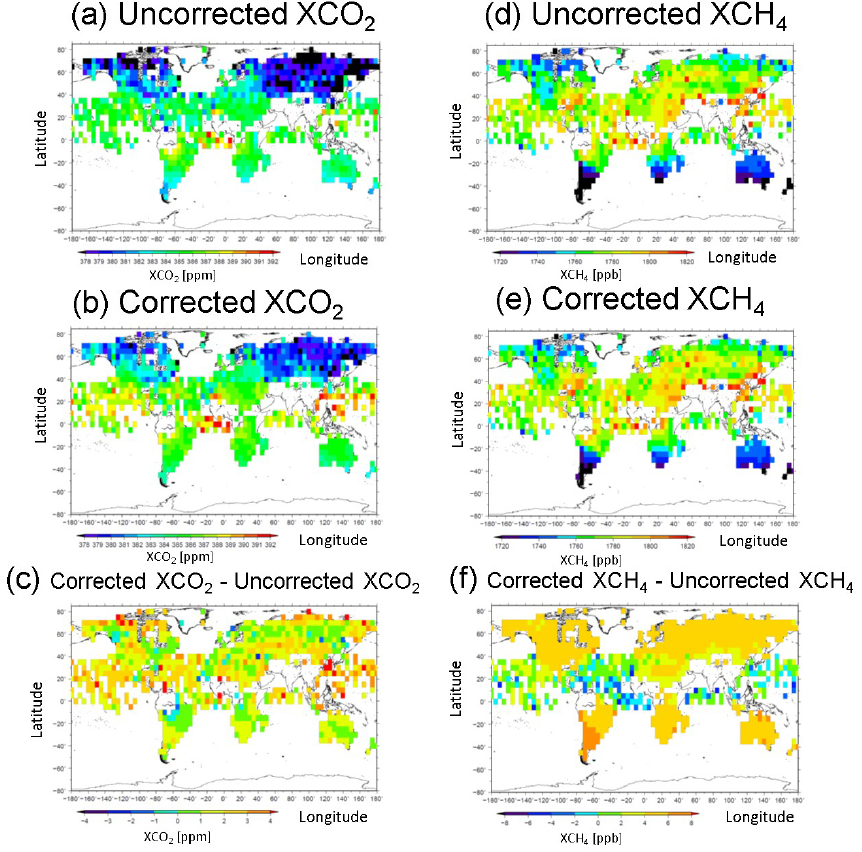
Figure 6. Global maps of the monthly means of (a) uncorrected and (b) corrected GOSAT XCO 2 , and (d) uncorrected and (e) corrected GOSAT XCH 4 in July 2009. GOSAT XCO 2 and XCH 4 data were binned in 5 ◦ by 5 ◦ grid elements. The differences between corrected and uncorrected (c) GOSAT XCO 2 and (f) GOSAT XCH 4